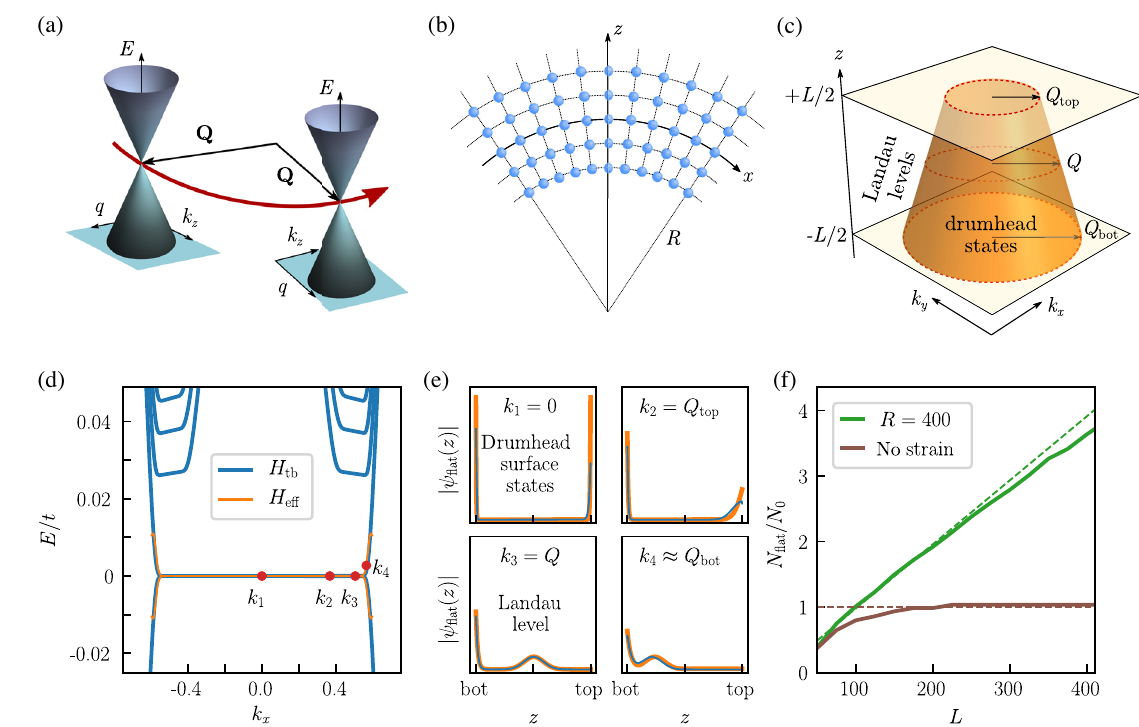
FIG. 1. (a) Schematic representation of a nodal-line semimetal band structure. Here, Q is a vector pointing to a momentum on the nodal line such that j Q j ¼ Q is the radius of a circular nodal loop. A Dirac cone is formed with respect to the perpendicular momentum components q and k z . (b) Example of a strain profile leading to the formation of a 3D flat band. The strain can be created, e.g., by bending the sample or growing it on a cylindrical surface. Here, R is the radius of the cylinder in the middle of the sample. (c) Bulk- boundary correspondence of the zeroth PLL of the NLSM. Because of the strain, the radius of the nodal circle varies as a function of z , such that the radius of the momentum-space area of the drumhead surface states on the top surface Q is different from the bottom top surface Q . Zeroth PLL bulk states appear in the momentum space region between Q and Q . (d) Spectrum of the model bot top bot Hamiltonian H [Eq. (1)] in the presence of strain [Eq. (2)] with parameters t 1 ¼ 0 . 25 t , t 2 ¼ 0 . 8 t , L ¼ 1000 , and R ¼ 8000 . For tb comparison, we also show the energies of the effective Hamiltonian H (orange bands) constructed from the analytical low-energy eff solutions (see Supplemental Material [38]). (e) Numerical (blue) and analytical (orange) wave functions of the zeroth PLL at different ; Q momenta k x ¼ k i ( i ¼ 1 , 2, 3, 4) indicated in panel (d). The drumhead surface states appear at both surfaces for j k x j < Q . At top bot j k j ¼ Q , the drumhead surface states from the top surface are deformed into the zeroth PLL bulk states and move towards the bottom x top < j k j < Q surface with increasing Q . At j k x j ¼ Q , the PLL bulk state hybridizes with the drumhead surface state at the bottom x top bot bot surface. (f) Degeneracy of the flat band as a function of the height L of the sample. Numerically, the degeneracy is calculated by integrating the density of states over an energy window ( j E j < 10 − 3 t ). The model parameters t 1 ; 2 are the same as in panel (d). Bold lines are the numerical results, and dashed lines correspond to the analytical formulas. In the presence of strain, the degeneracy grows linearly with L , demonstrating the existence of a 3D flat band with degeneracy N proportional to the volume of the sample (green dashed line). flat In the absence of strain, the degeneracy of the zero-energy drumhead surface states saturates with increasing L , demonstrating that it is proportional to the area of the surface of the sample, N 0